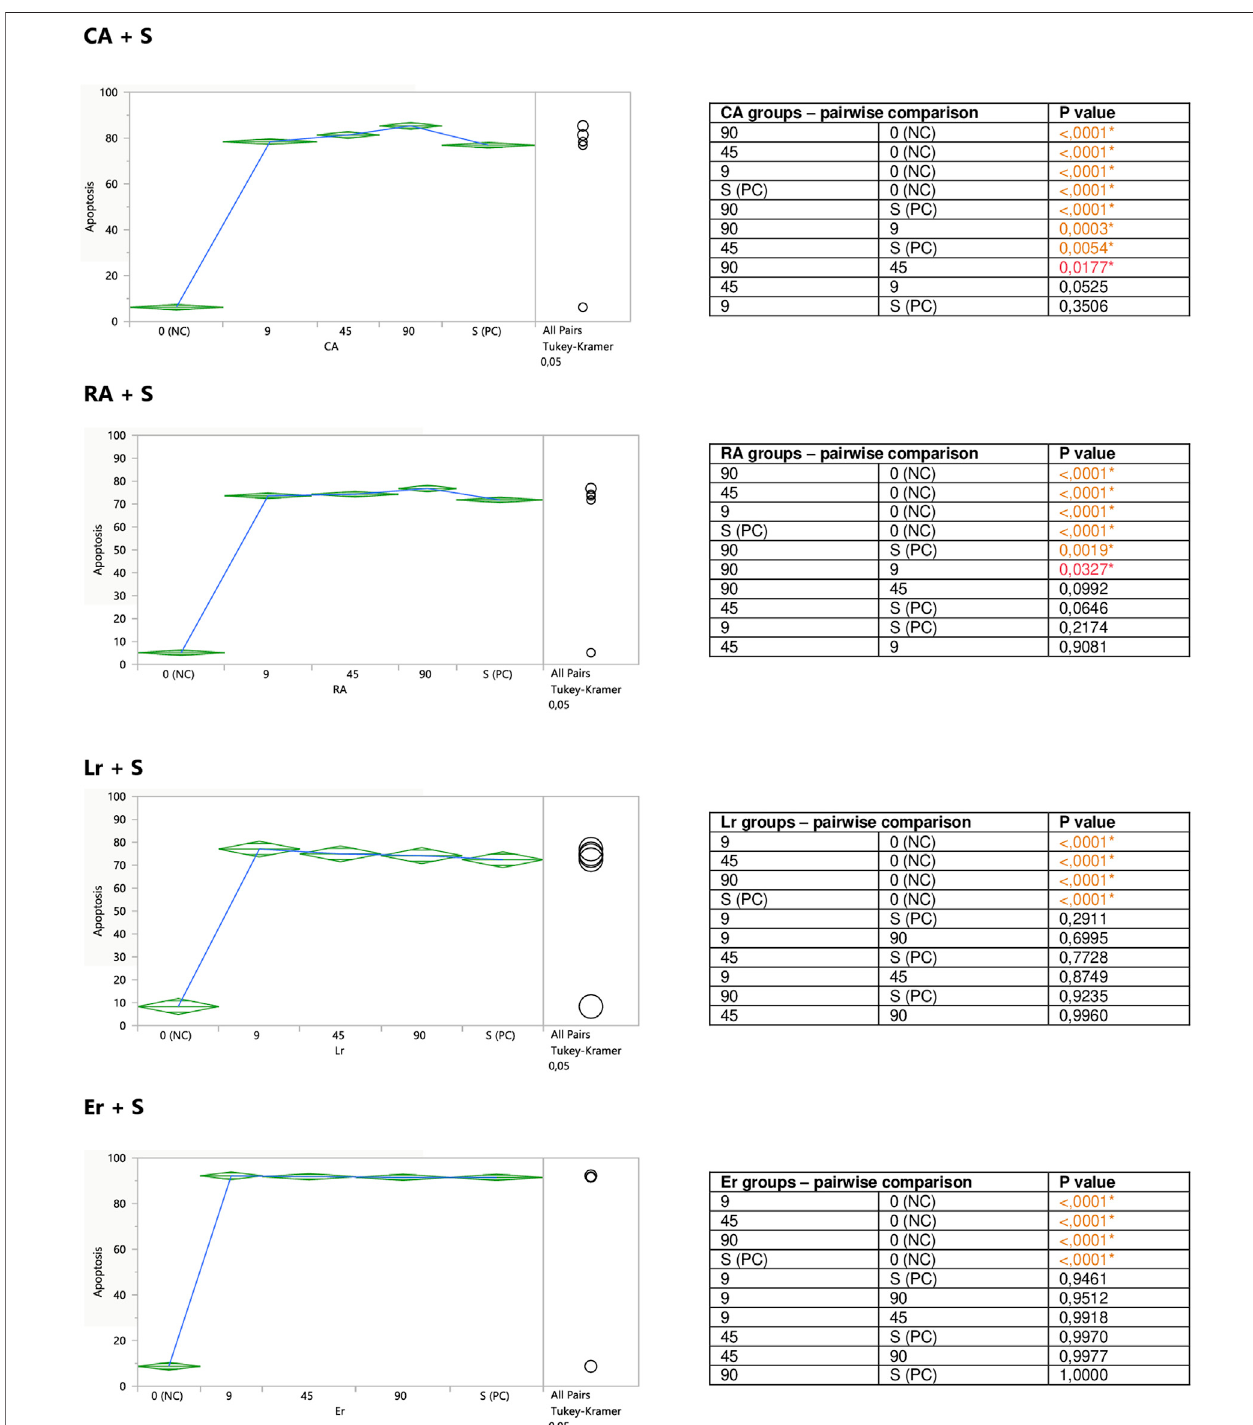
FIGURE 7 | Modulatory effect of CA, RA, Lr, and Er on staurosporine-induced apoptosis of Jurkat cells. 0 (NC) = negative control (untreated Jurkat cells); S (PC) = positive control (Jurkat cells treated with staurosporine); 9, 45, 90 = Jurkat cells incubated with a given (poly)phenol at the concentration of 9, 45, or 90 μ M, and subsequently treated with staurosporine. Apoptosis = percent of apoptotic cells. Means diamonds illustrate ANOVA analysis (upper and bottom points are at 95% con fi dence points of each group). The circles on the right express signi fi cant differences between group means (if they do not overlap) or the lack of signi fi cant differences (if they